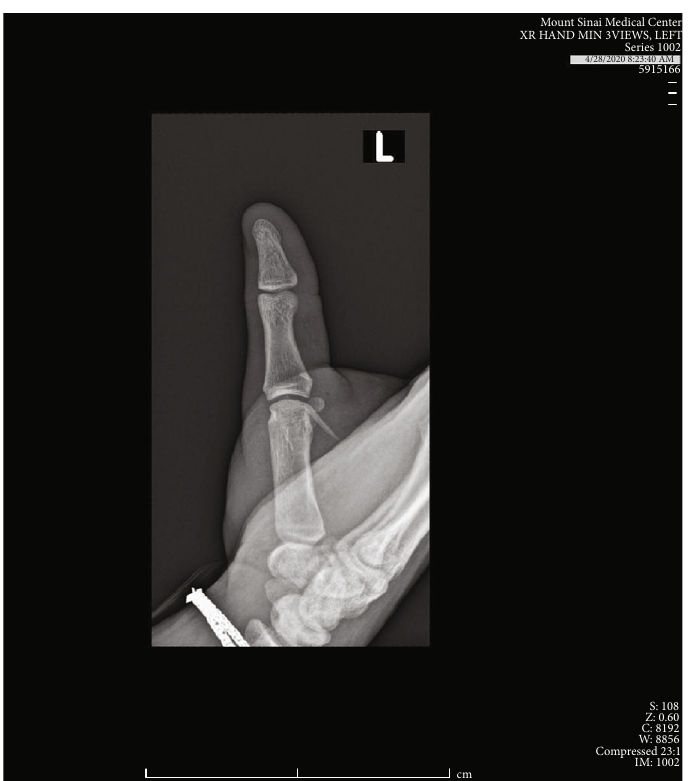
Figure 3: Additional coned-in view of the left thenar region demonstrating a linear foreign body.